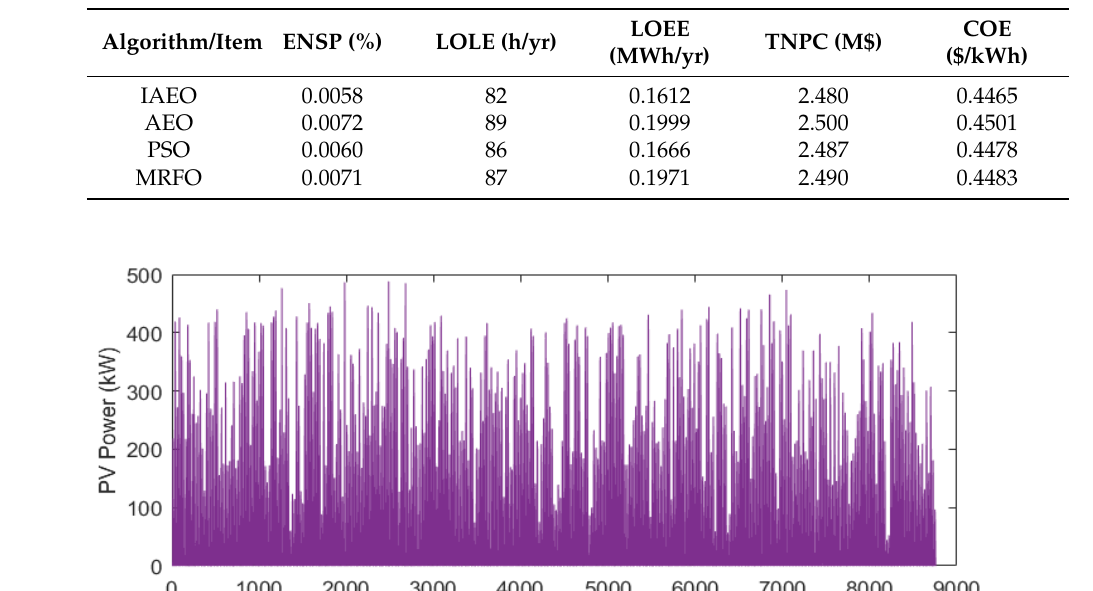
Table 4. Reliability and cost results of HPV/FC energy systems considering ENSP max = 1%.